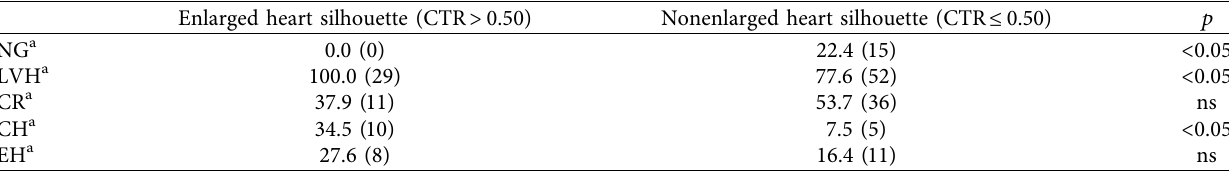
Table 3: Geometry of the left ventricular in the studied subgroups differing in cardiothoracic ratio.